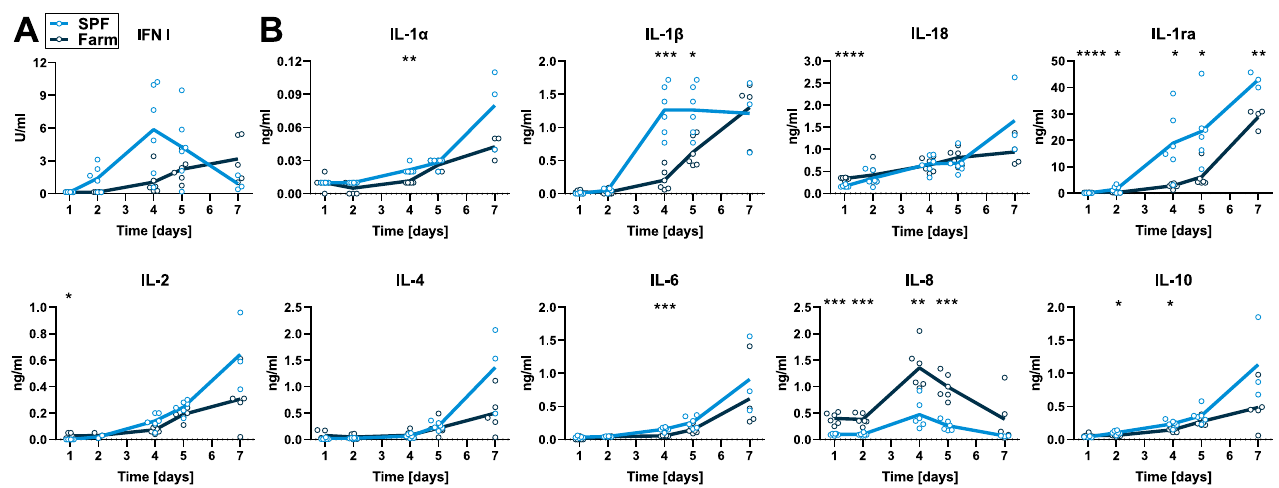
Fig 5. Serum cytokines after infection with virulent ASFV Armenia 2008. Blood samples were taken on 1, 2, 4, 5, and 7 dpi. (A) IFN type I activity in serum was measured by bioassay. (B) Cytokine levels were determined by multiplex ELISA. Data points show values for individual animals and lines indicate mean of each group at indicated dpi. Differences between SPF and farm groups were analyzed by unpaired t test at each dpi with Holm-Sidak’s correction for multiple comparisons (n = 6 pigs/group, except 7 dpi, where n = 3 for SPF group). � p < 0.05, �� p < 0.01, ��� p < 0.001, ���� p < 0.0001.